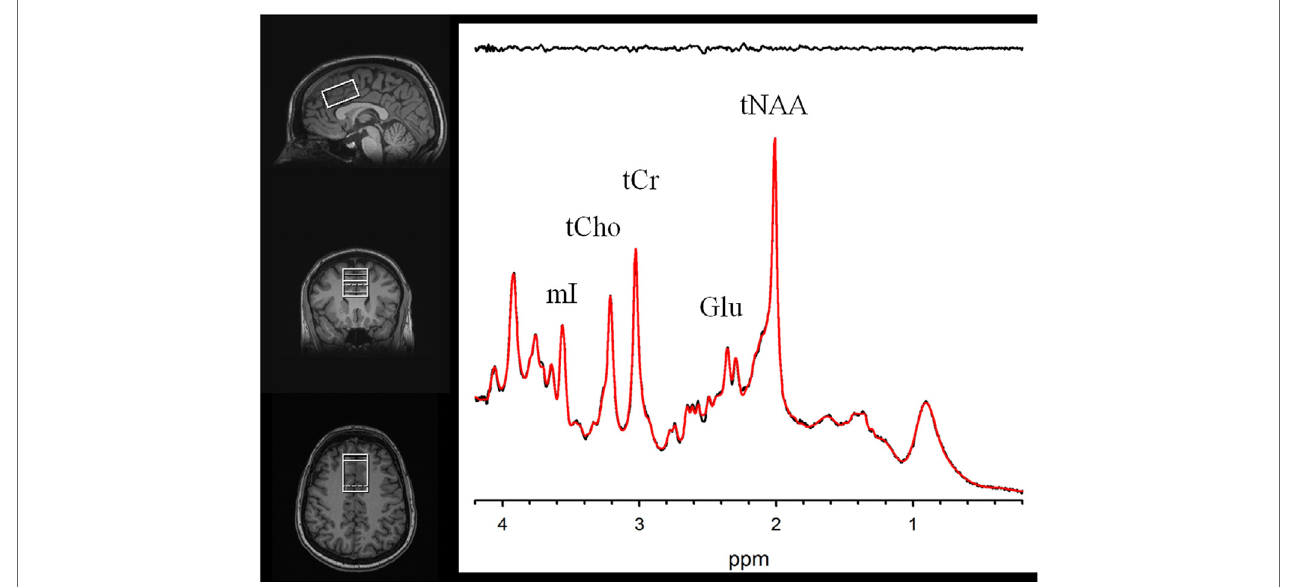
FigUre 1 | Voxel images and a representative spectrum (black line), LCModel fit (red line), residual (black line at top). Myoinositol (mI), Phosphocreatine+Creatine (tCr), Phosphorylcholine+Glycerophosphorylcholine (tCho), Glutamate (Glu), and N-Acetylaspartate